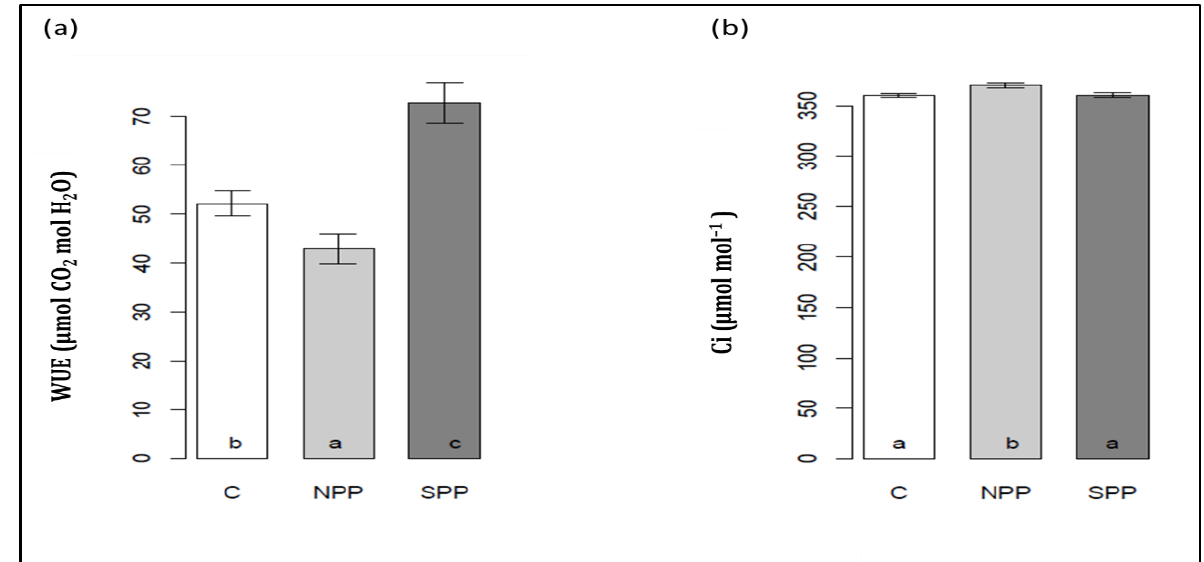
Figure 6. Changes in water-use efficiency (WUE) ( a ) and intercellular CO 2 assimilation (Ci) ( b ) of primed and nonprimed olive leaves subjected to subsequent drought. Significant differences be- tween the means (at p < 0.05, according to ANOVA) appear with different letters. Values are means ± standard error ( n = 6), where ‘ n ’ is the number of replicates for each group.